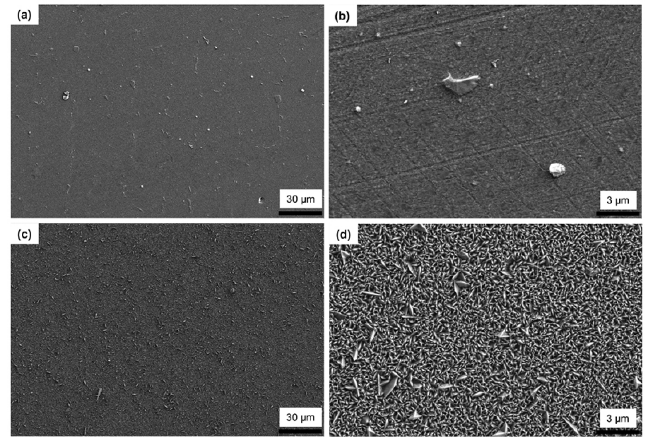
Figure 4. SEM micrographs showing TiN deposited on the mirror-polished Co–Cr alloy surfaces by PVD and CVD. ( a ) and ( b ): PVD TiN (low (500×) and high (5000×) magnifications, respectively). ( c ) and ( d ): CVD TiN (low (500×) and high (5000×) magnifications, respectively).